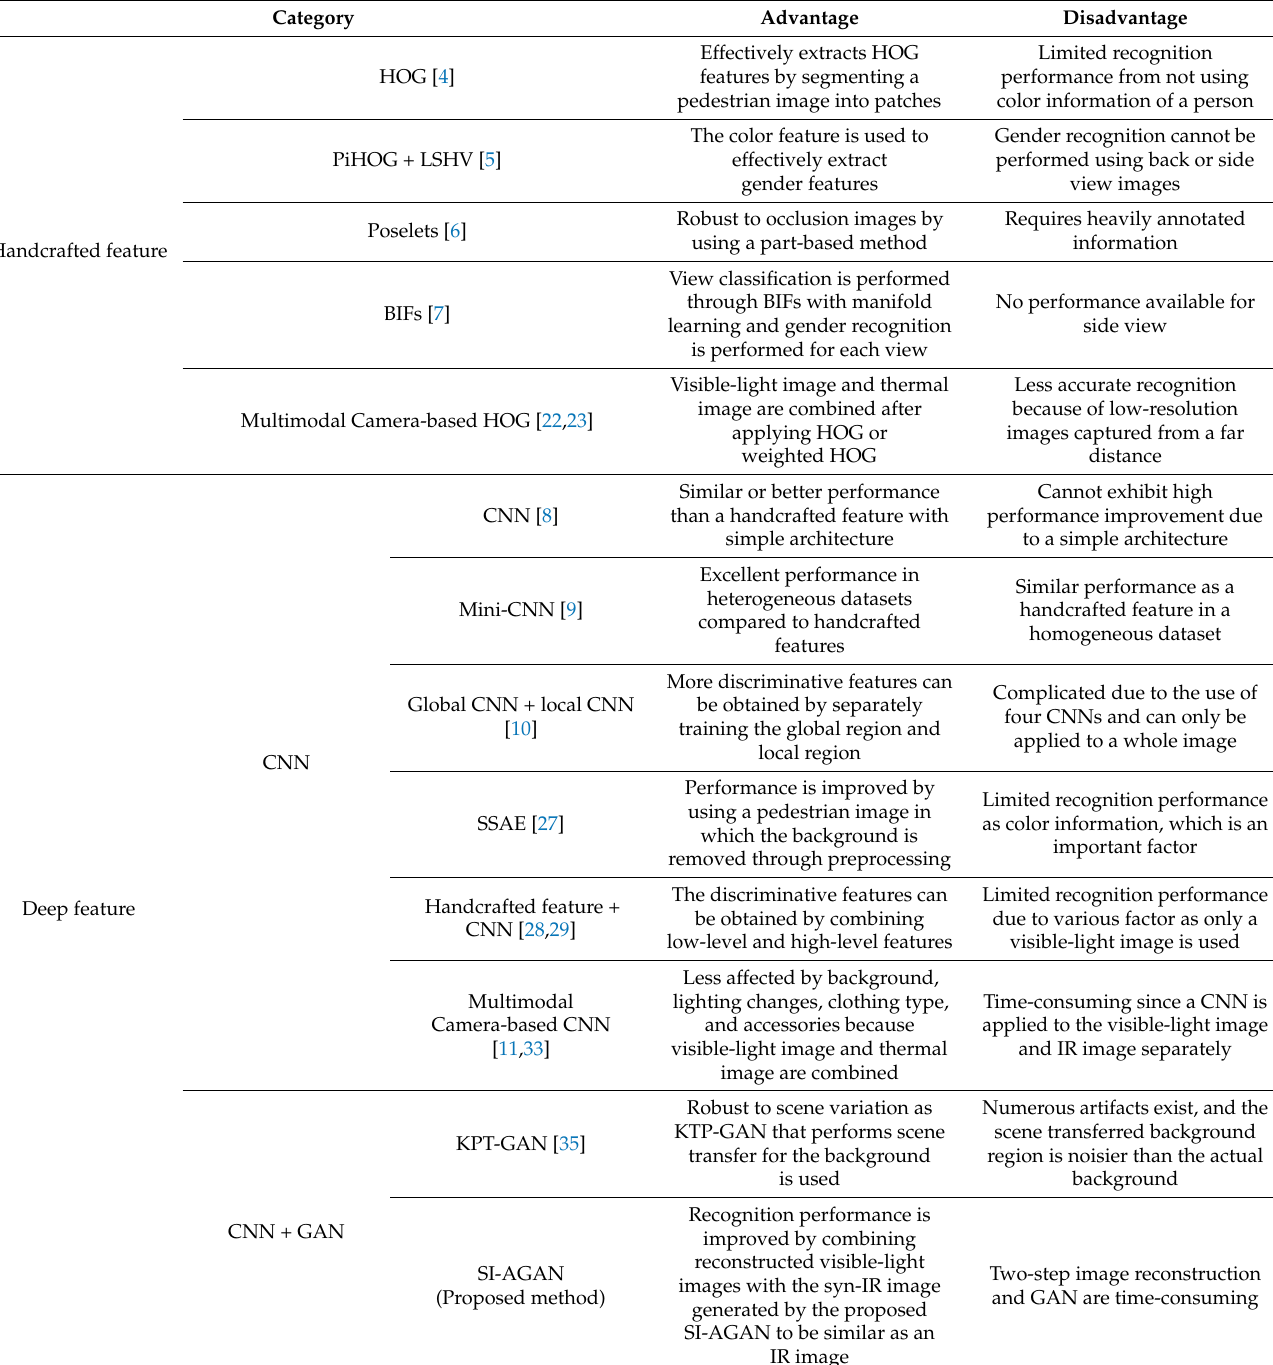
Table 1. Comparison of the previous and the proposed methods for pedestrian gender